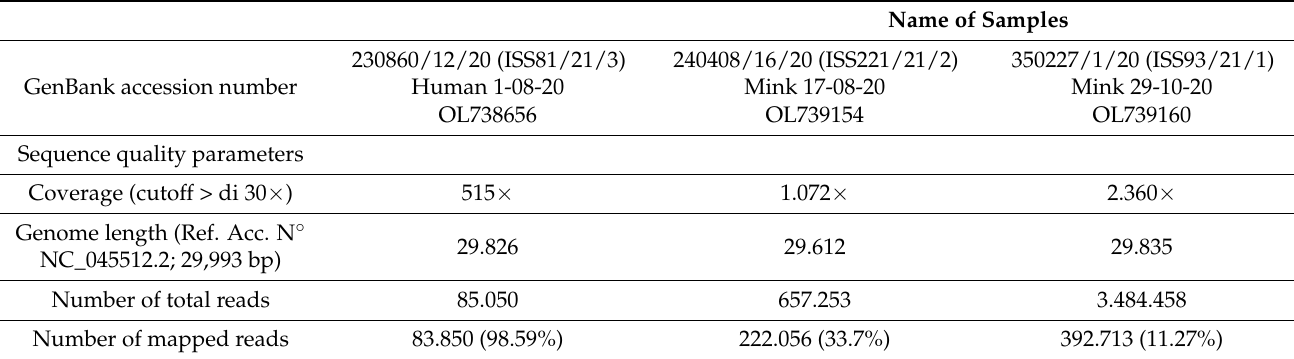
Table 2. Quality values of the sequence data